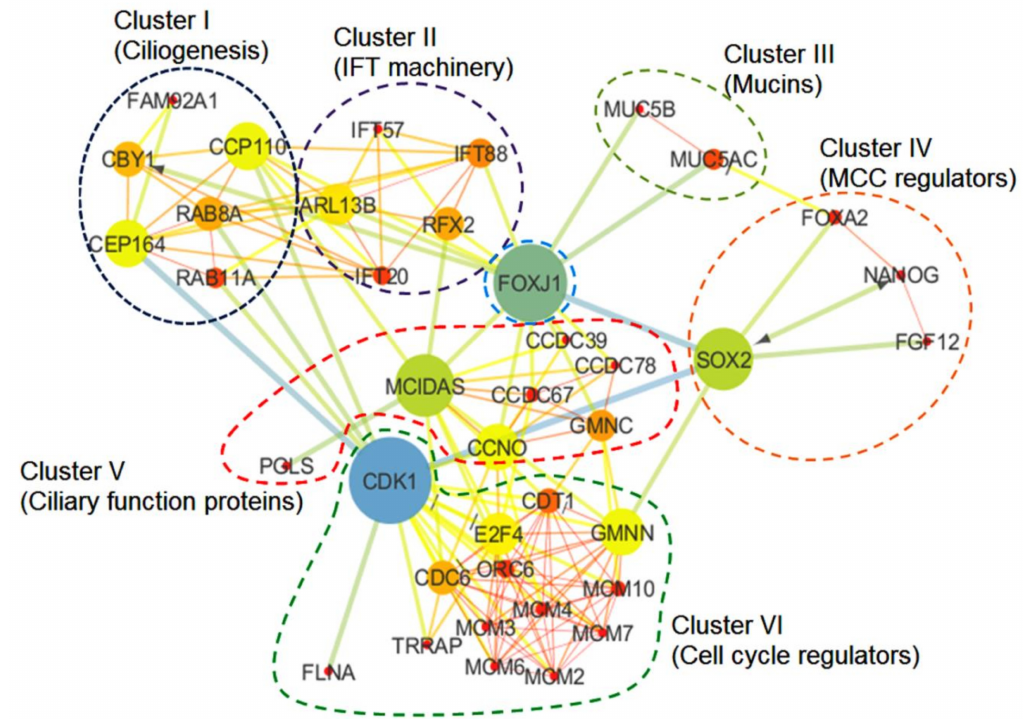
Figure 2. The mucociliary clearance (MCC) regulatory protein network. The principal nodes and paths that drive the mucociliary clearance regulatory protein network were analyzed using Cytoscape 3.7.2. The protein network analysis was performed by using the betweenness centrality algorithm where the sizes of the nodes (circles) indicate betweenness. The color scale ranges from blue–green–yellow to orange, which is indicative of low to high betweenness values, respectively. The clustering analysis was performed by employing the Markov clustering (MCL) algorithm. The perforated shapes represent different clusters